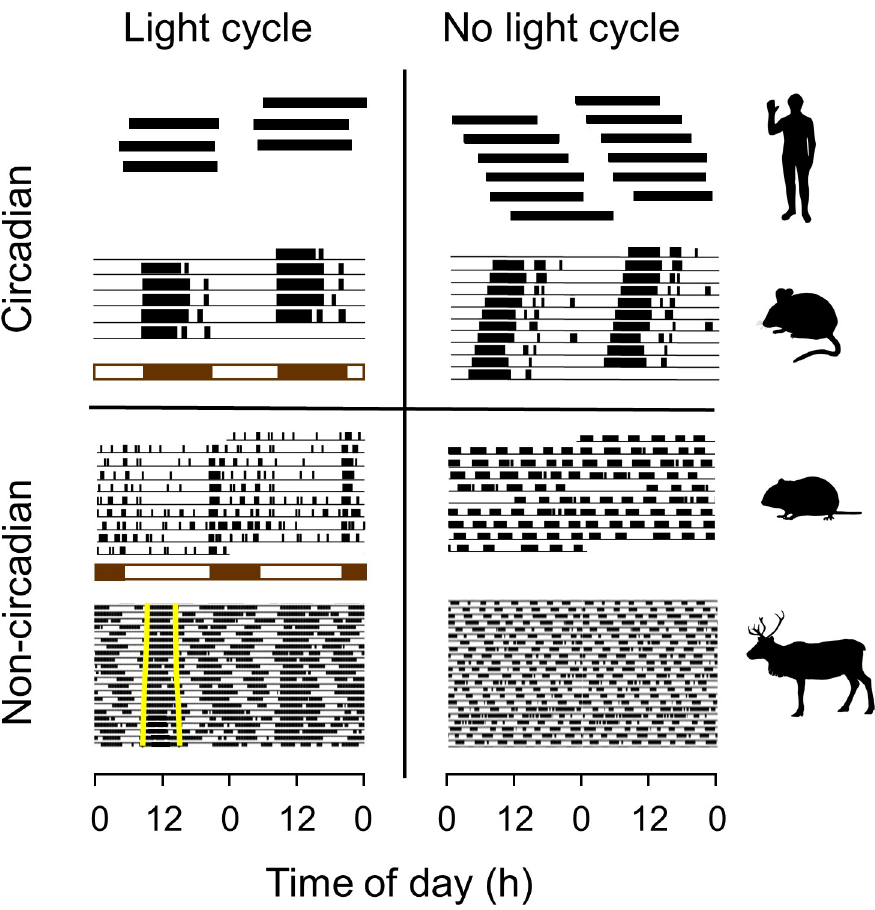
Fig 1. Circadian organisation is not ubiquitous in mammals. Activity patterning in (from the top) humans, mice ( Mus musculus ), voles ( M . arvalis ), and reindeer ( R . tarandus ) under 24-h LCs and NLCs. All four species display pronounced 24-h rhythms of activity under LC. These rhythms persist under NLC in humans and mice but not in voles and reindeer. Data for humans are from bunker experiments in which subjects were initially exposed to changes in light intensity synchronised to the solar day (LC) and then allowed to free-run with only self-imposed changes in light level (NLC [6]). For mice and voles, experimental light and dark phases are represented by horizontal white and brown bars, respectively. For the reindeer, free-living in their natural environment, natural photoperiod (onset and offset of civil twilight) is indicated by vertical yellow lines on the first day of each actogram, and the NLC regime was the polar night at 78˚ north latitude. Data for one individual of each species under each light regime are presented as double-plotted actograms. Black bars represent activity. LC, light–dark cycle; NLC, no-light cycle. Redrawn from [6–9] .